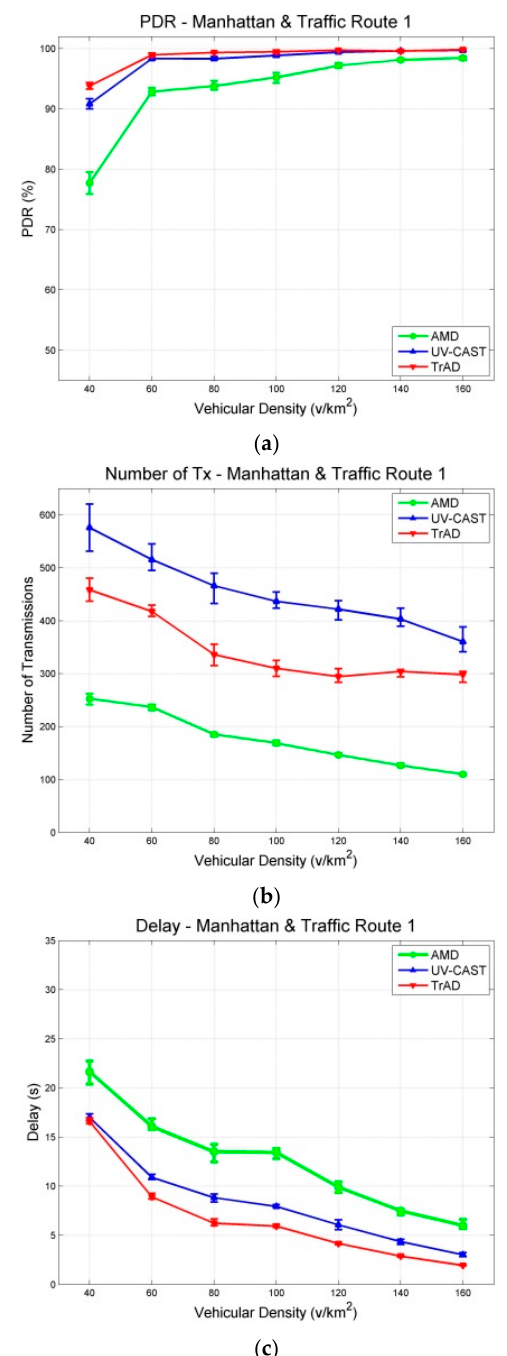
Figure 8. Results with a 95% confidence interval in Manhattan scenarios with the traffic route 1 (uniform): ( a ) PDR; ( b ) Number of Transmissions; ( c ) Delay. (uniform): ( a ) PDR; ( b ) Number of Transmissions; ( c )